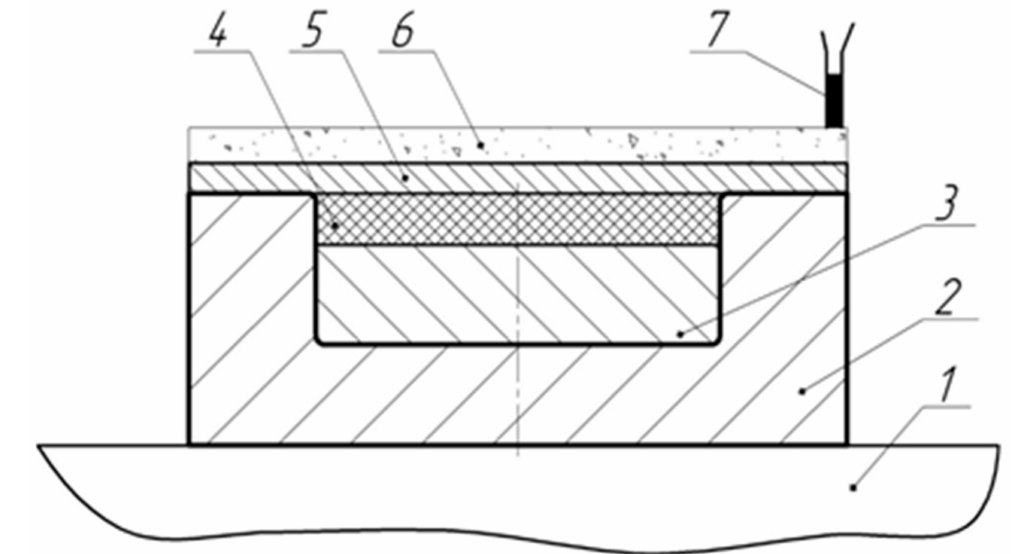
Figure 4. Powder activation scheme by explosive loading: 1, explosion chamber desktop; 2, mold;